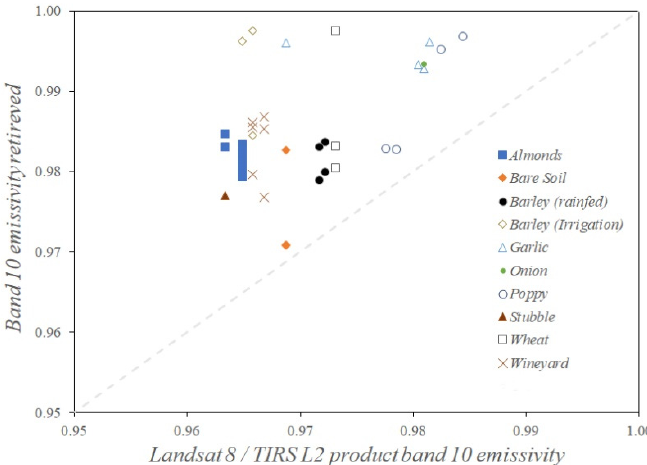
Figure 7. Emissivity values for band 10 of L8 estimated following the methodology described in Section 2.3.1, against those provided by the L8 L2SP product. Dashed line represents the 1:1 agree- ment.